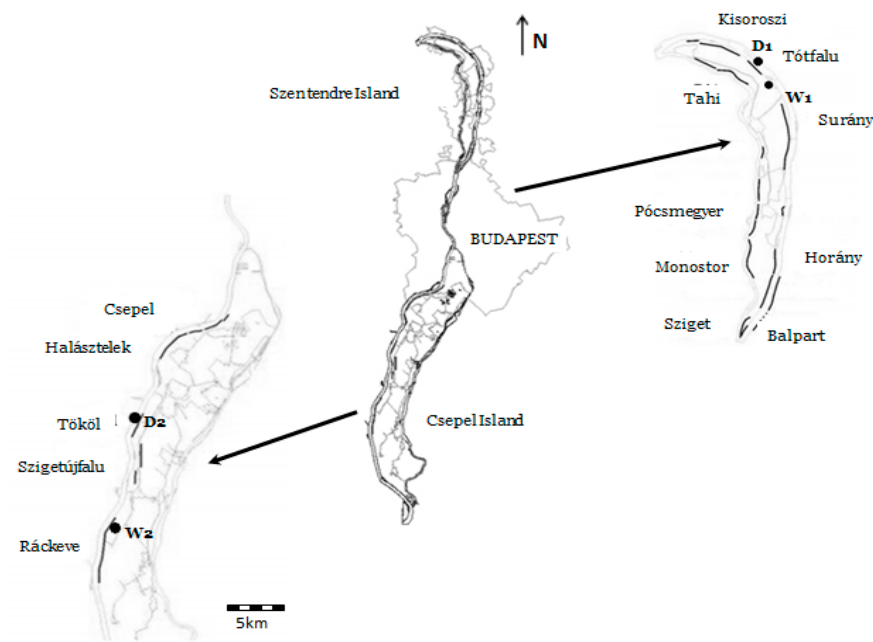
Figure 1. Danube River water and bank filtrate sampling points with the names of well groups on Szentendre Island and Csepel Island in Budapest. D 1 : Danube River water sampling point upstream of Budapest. W 1 : Bank filtrate sampling point upstream of Budapest. D 2 : Danube River water sampling point downstream of Budapest. W 2 : Bank filtrate sampling point downstream of Budapest.